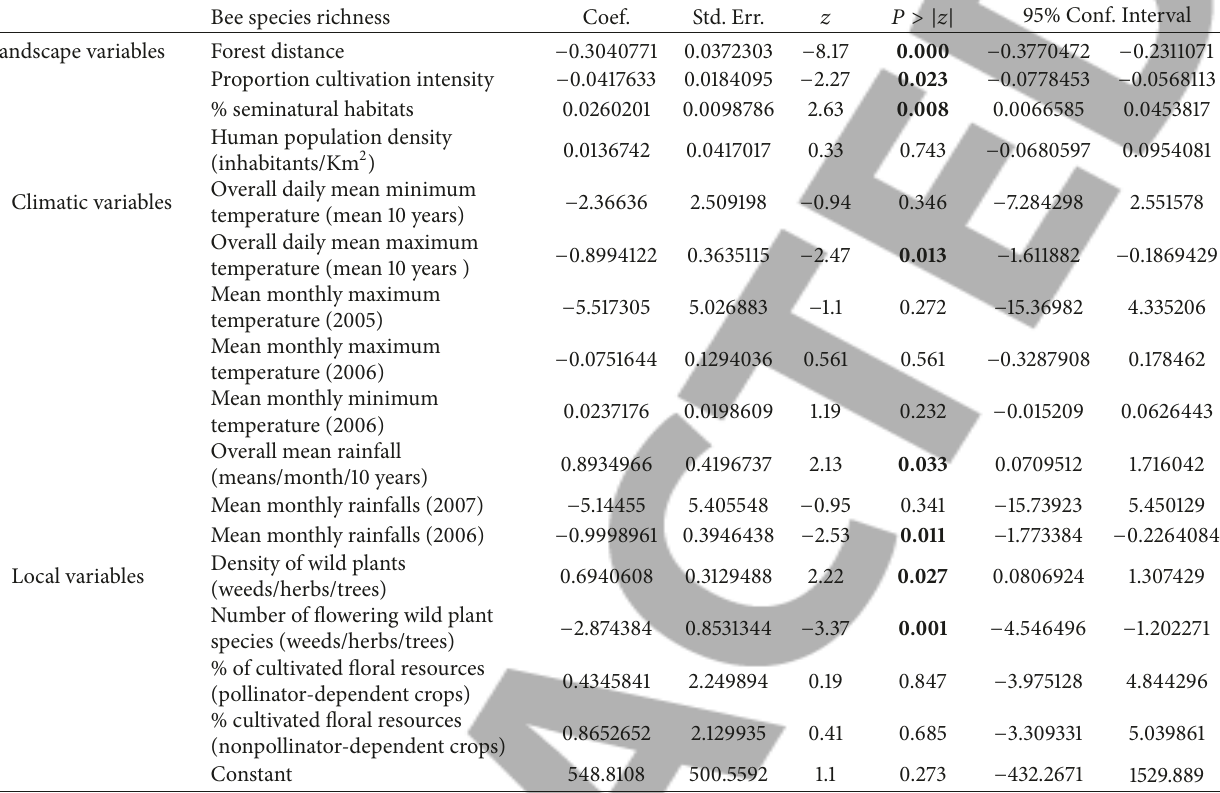
Table 2: Generalized linear models (GLMs) testing the effects of local, landscape, and climatic factors on bee abundance and species richness in farmlands of central Uganda. Bee species richness Coef. Std. Err. 𝑧 𝑃 > |𝑧| 95% Conf. Interval Landscape variables Forest distance −